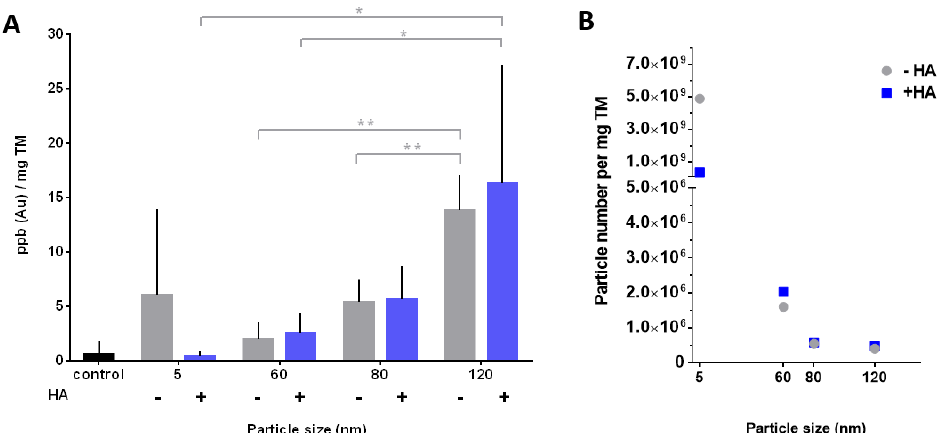
Figure 4. Gold content and the particle number in the trabecular meshwork (TM) after ex vivo perfusion with gold NPs. ( A ) The amount of gold per mg tissue in the trabecular meshwork was analyzed using the data from Figure 3. Grey bars represent the trabecular meshwork samples perfused with AuNPs, and blue bars represent the samples perfused with HA-AuNPs. The control is shown in the black bar. Larger particles led to a significantly higher gold content in the trabecular meshwork than smaller particles, except for the 5 nm AuNPs. Statistically significant differences are denoted by * or ** ( p < 0.05 or p < 0.01, respectively). ( B ) The gold content per mg trabecular meshwork was calculated to obtain the particle number per mg trabecular meshwork. The smallest gold NPs showed the highest number of incorporated particles, but larger particles reflect the higher overall particle volume.